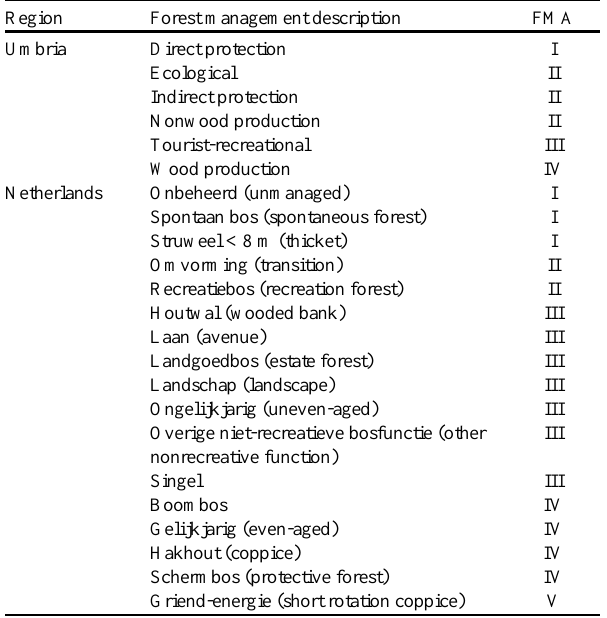
Table 5 . Number of stands assigned to each forest management approach (FMA) for the whole of Europe before aggregating to pixel level. (FMA I: nature reserve; II: close-to-nature; III: